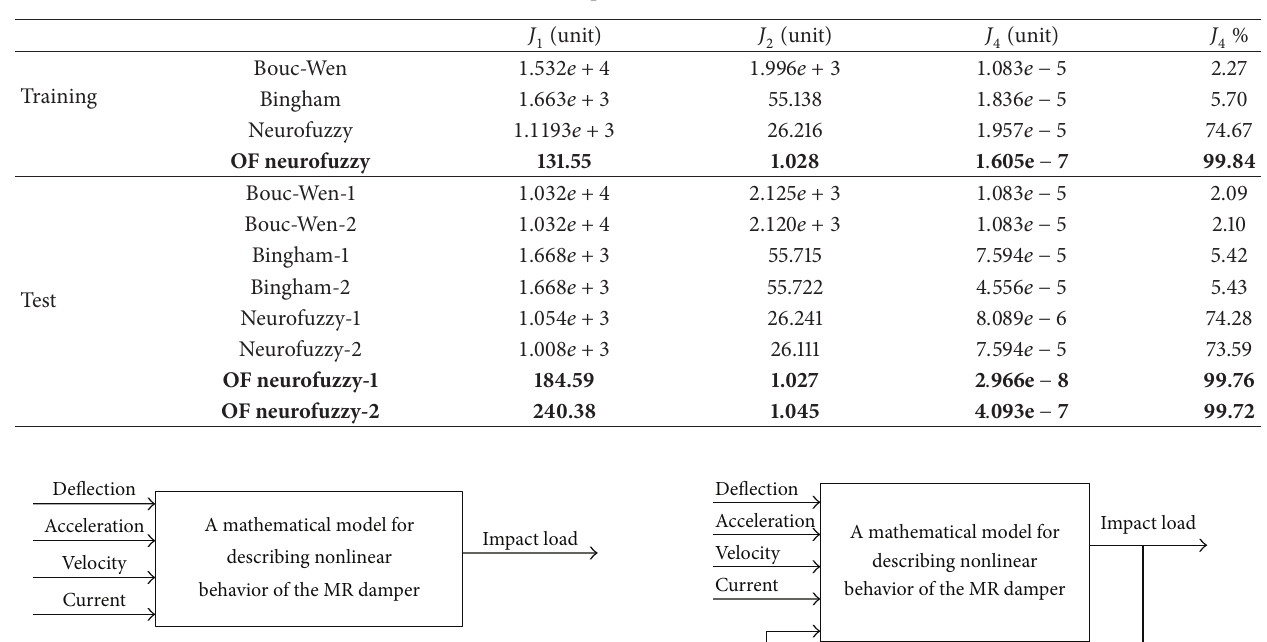
Table 7: Error quantities of the SI models.